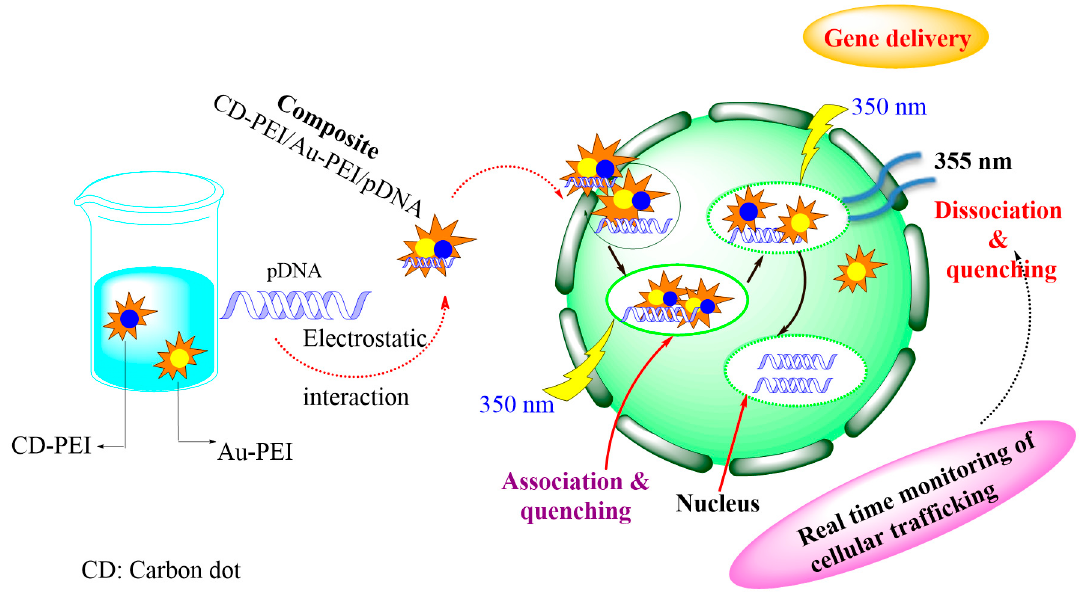
Figure 11. Schematic chart of gene delivery of CQDs.